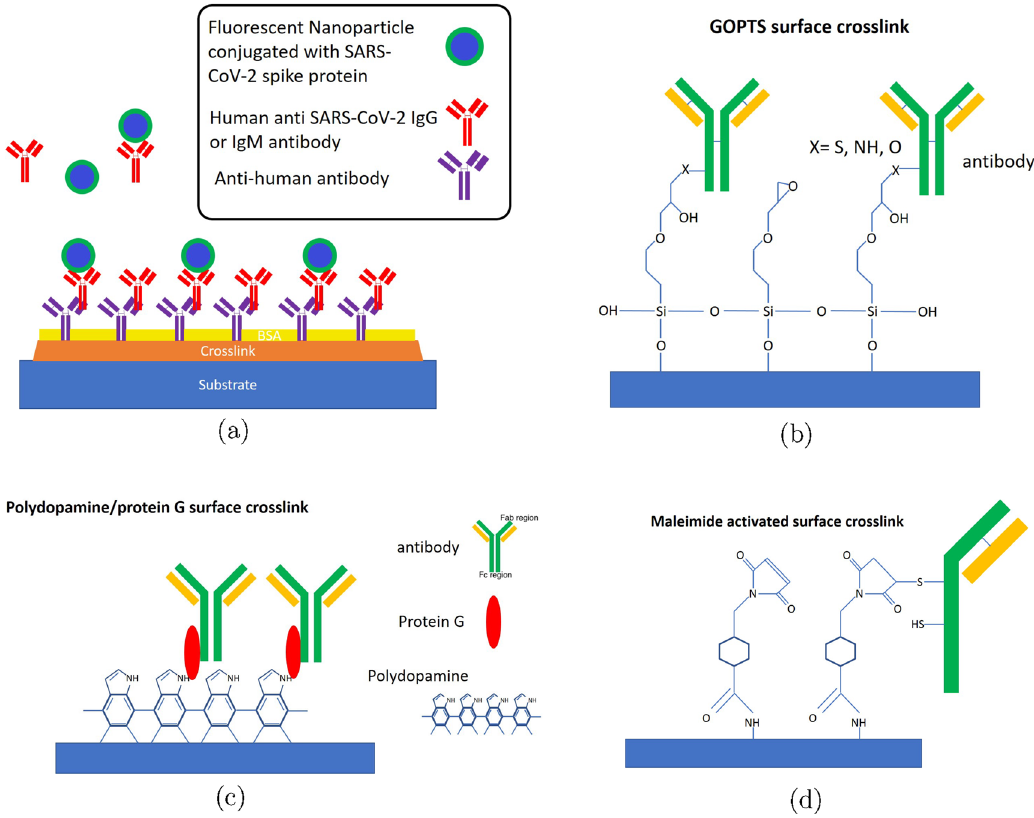
Figure 7: Schematic of substrate assay for detecting human anti-Severe Acute Respiratory Syndrome-Corona Virus-2 (SARS-CoV-2) IgG and IgM. The substrate is the inner surface of a hollow-core fiber optic. The cross-links we can use are 3-glycid-oxy-propyl-trimethoxy-silane (GOPTS), protein A or polydopamine/protein G, or amine-maleimide. The Bovine Serum Albumin (BSA) layer is used to block any other active part of the substrate. The human IgG and IgM bind to antihuman antibody by their Fc region, while the Fab region binds to spike proteins immobilized on the surface of a Figure 8. In this type of setup, a drop of blood mixed with a buffer solution is placed on the sample pad and wicked by capillary action into the conjugation pad which con- tains gold nanoparticles coated with spiked protein from the SARS-CoV-2. In such a case, the spike protein- a virus and the antibody binds to the coated AuNP.